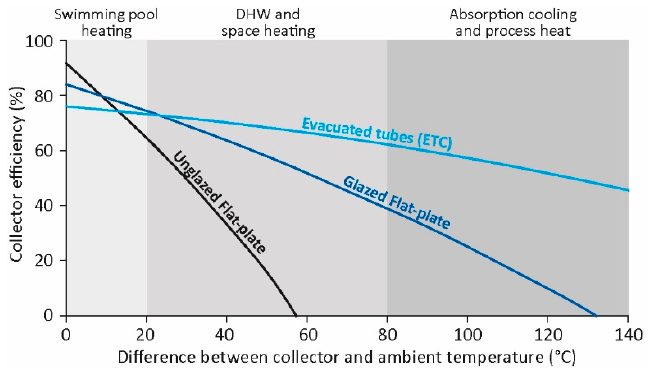
Figure 1. Graph of thermal collector efficiency vs. temperature.